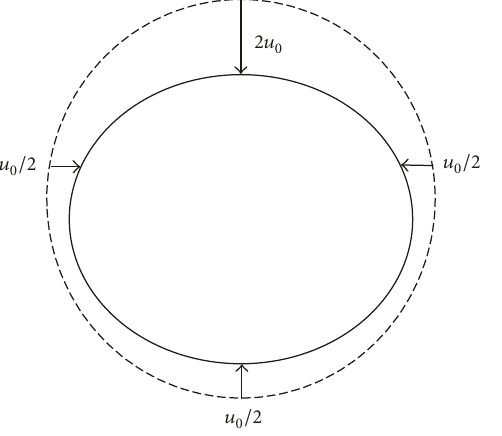
Figure 2: Boundary condition of displacement.